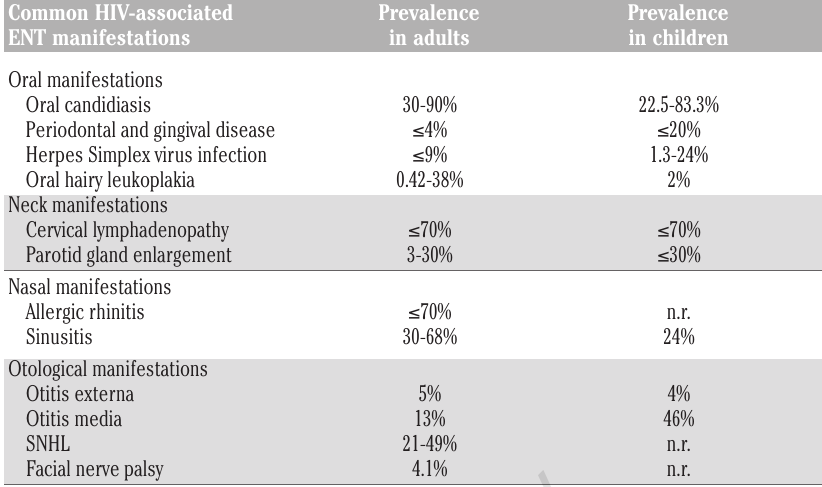
Table 2. Prevalence of HIV-associated ear, nose and throat (ENT) manifestation in adults and